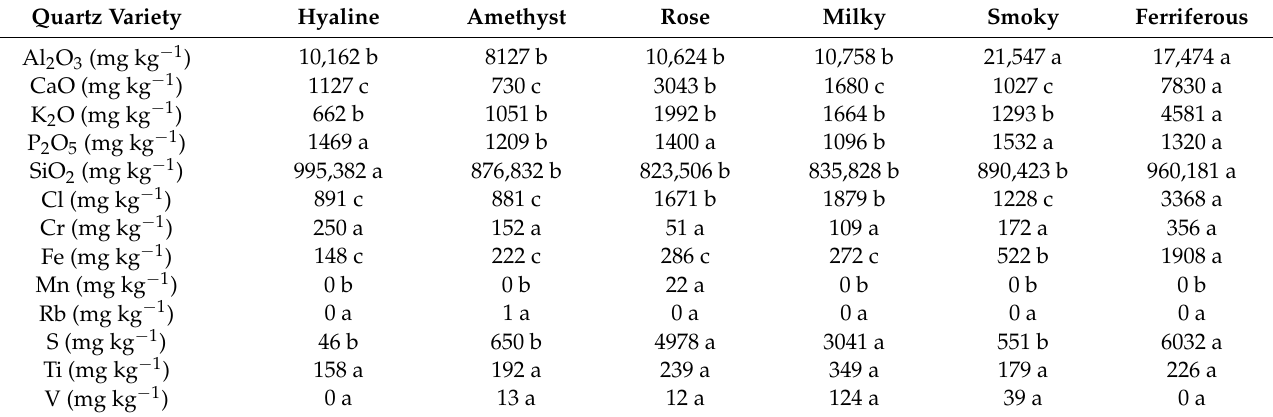
Table 2. Mean values of elements and oxides of the different varieties of quartz, where the same letters in the same line express statistically equal values according to the Scott–Knott test at a 5% significance